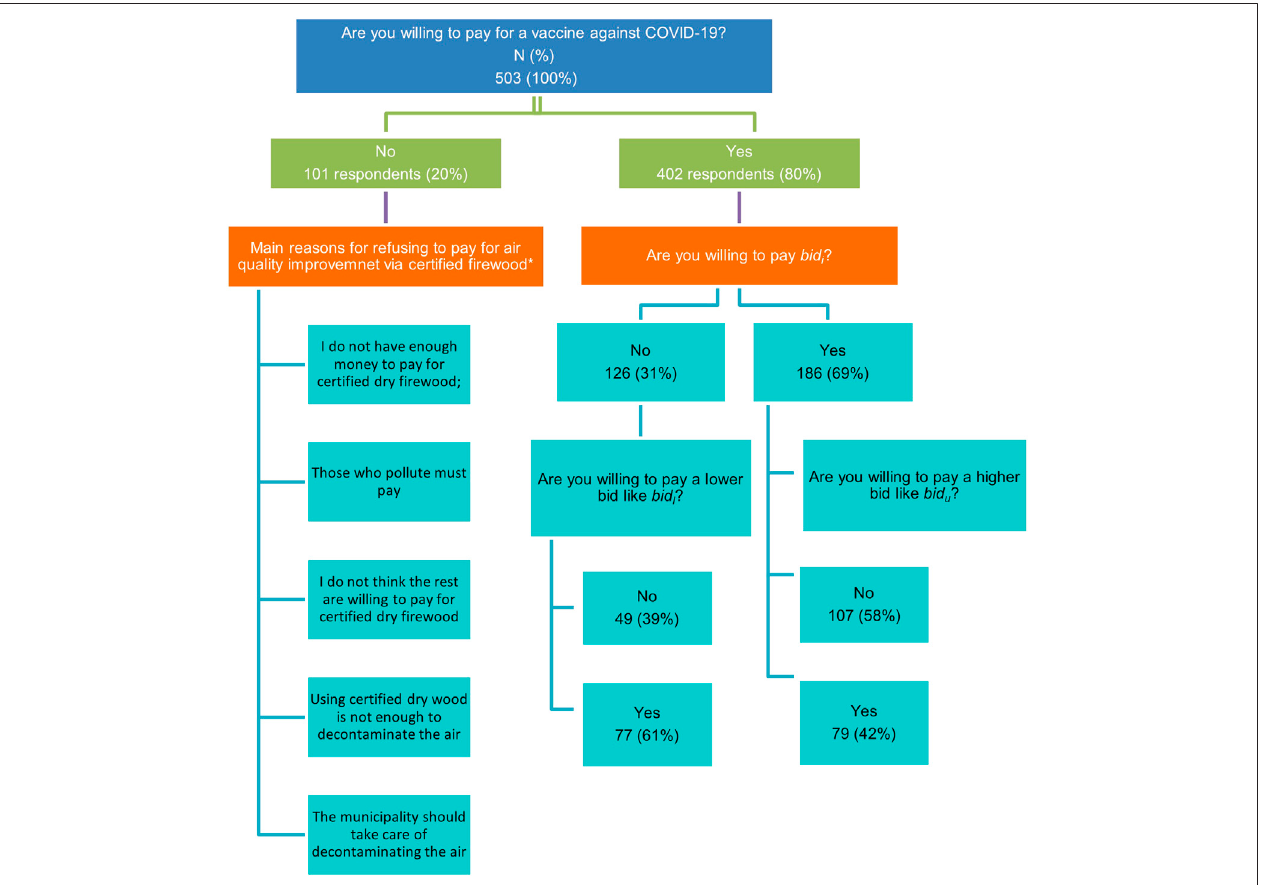
FIGURE 1 | Sample distribution of willingness to pay and refusal reason frequencies. Note: bid i = initial payment vector, bid l = lowest bid with respect to initial payment vector, and bid u = highest bid with respect to initial bid i , for i = 1 to 10 (quantity of offers). See the values of the bids and sampling distribution in Table 1 . Additional, respondents (101) could choose more than one option when rejecting willingness to pay (WTP).